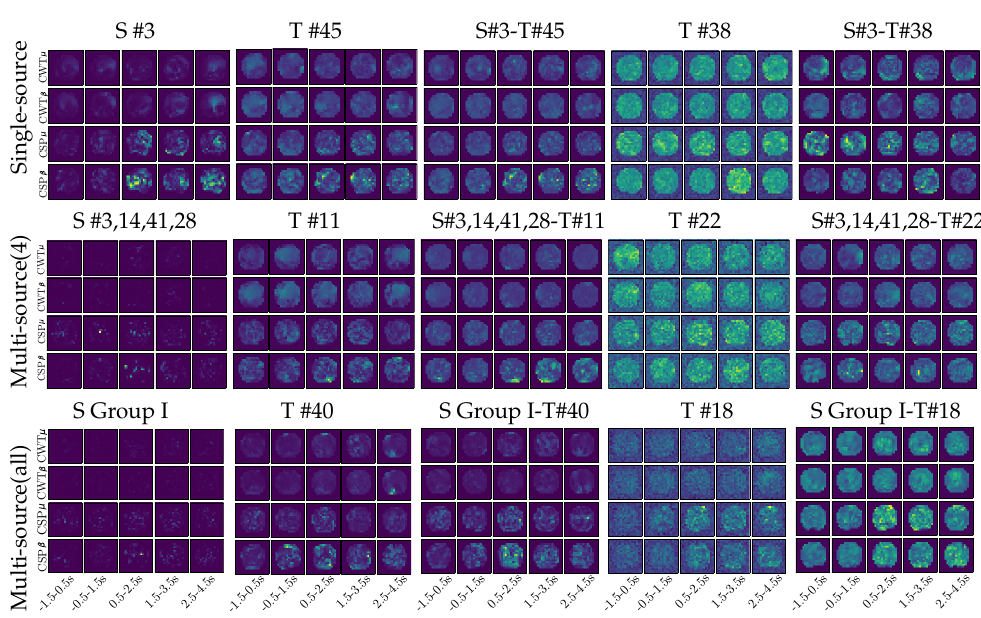
Figure 6. Topographic maps of representative subjects with and without transfer learning using just feature map information, presenting the learned weights with meaningful activity reconstructed within both bandwidths ( β and µ ) across the whole signal length, N τ